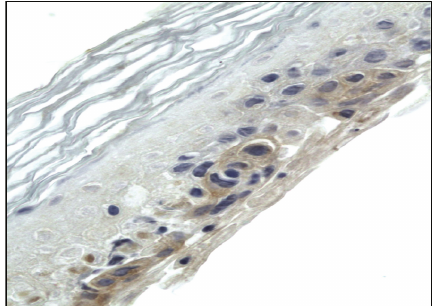
Figure 2: Fas immunoexpression in the cytoplasm of keratinocytes, (score 2), 400x.